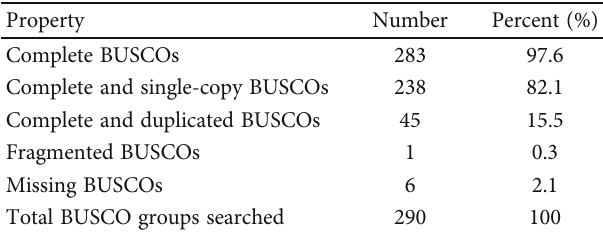
Figure 1: Distribution of 17-mers in H. coralloides genome. X -axis is 17-mer deep ( X ); Y -axis is the number of sequencing reads at that depth. Table 4: Evaluation of integrity and continuity of genome assembly.